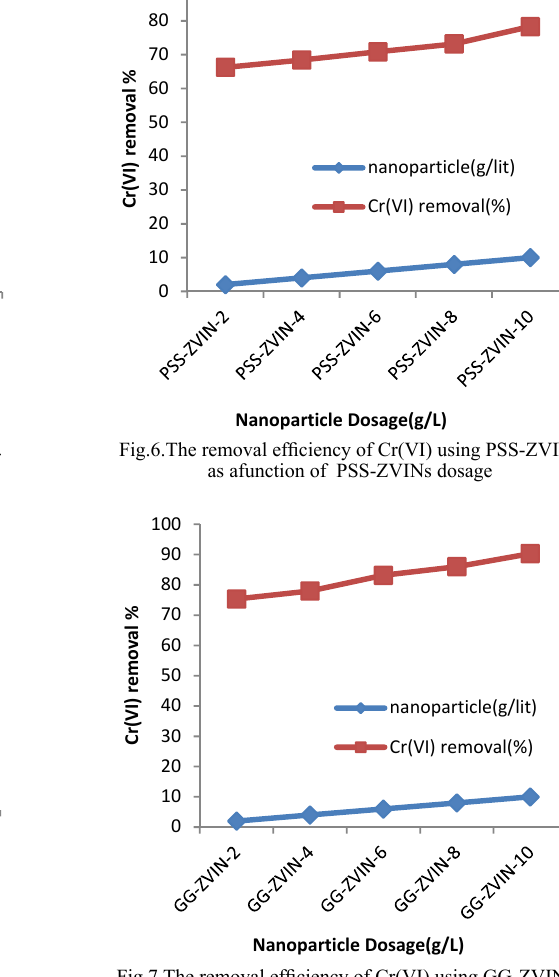
Fig.7.The removal efficiency of Cr(VI) using GG-ZVINs as afunction of GG- ZVINs